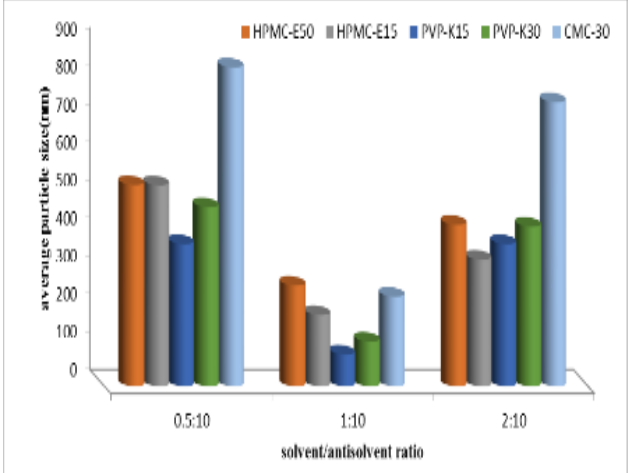
Figure 4. Effect of solvent:anti solvent ratio on the average size (n=3) of